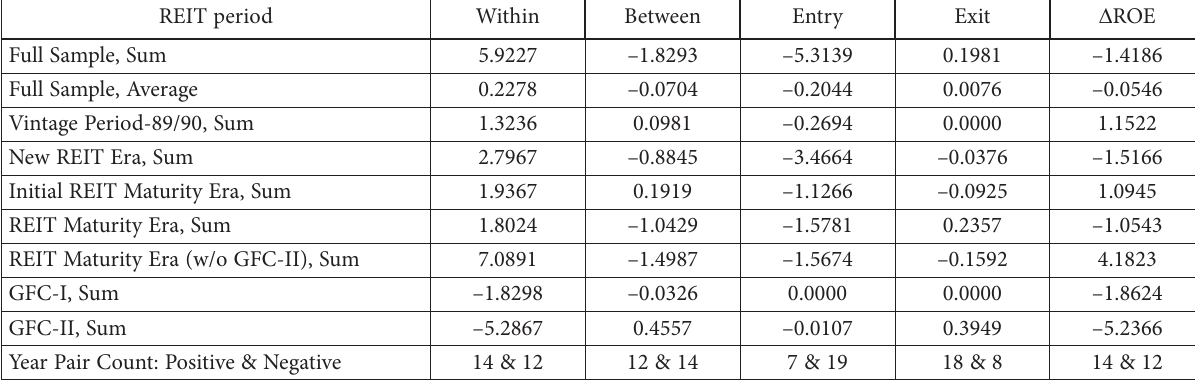
Table 4. Evolution of the Bennet dynamic decomposition, funds from operations based ROE: 1989–2015 Panel A: Cumulative; full sample; entire sample period and REIT sub-period